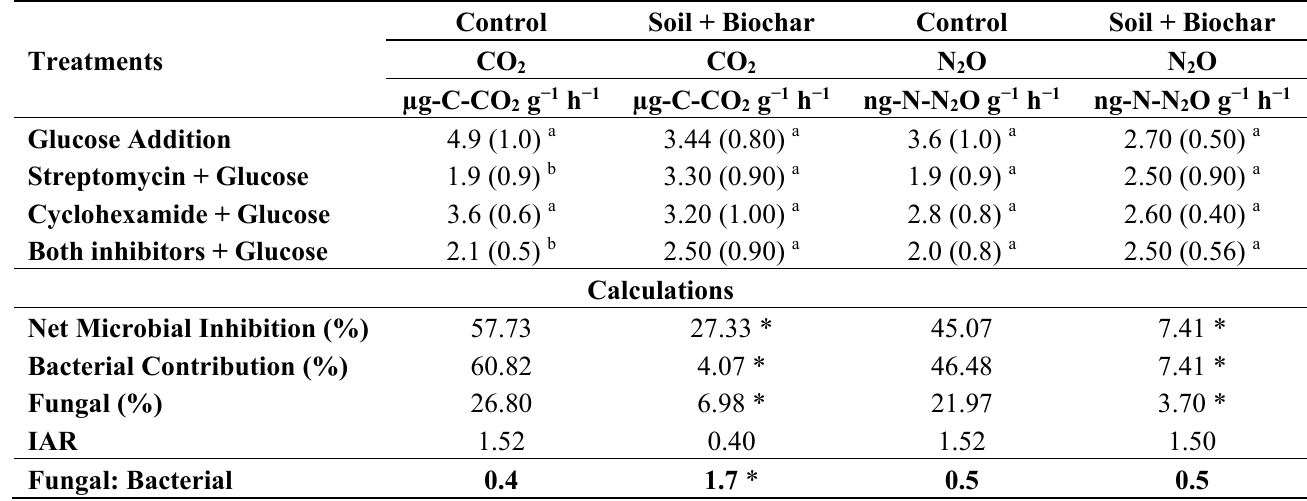
Table 4. Selective inhibitor incubation results for the forest